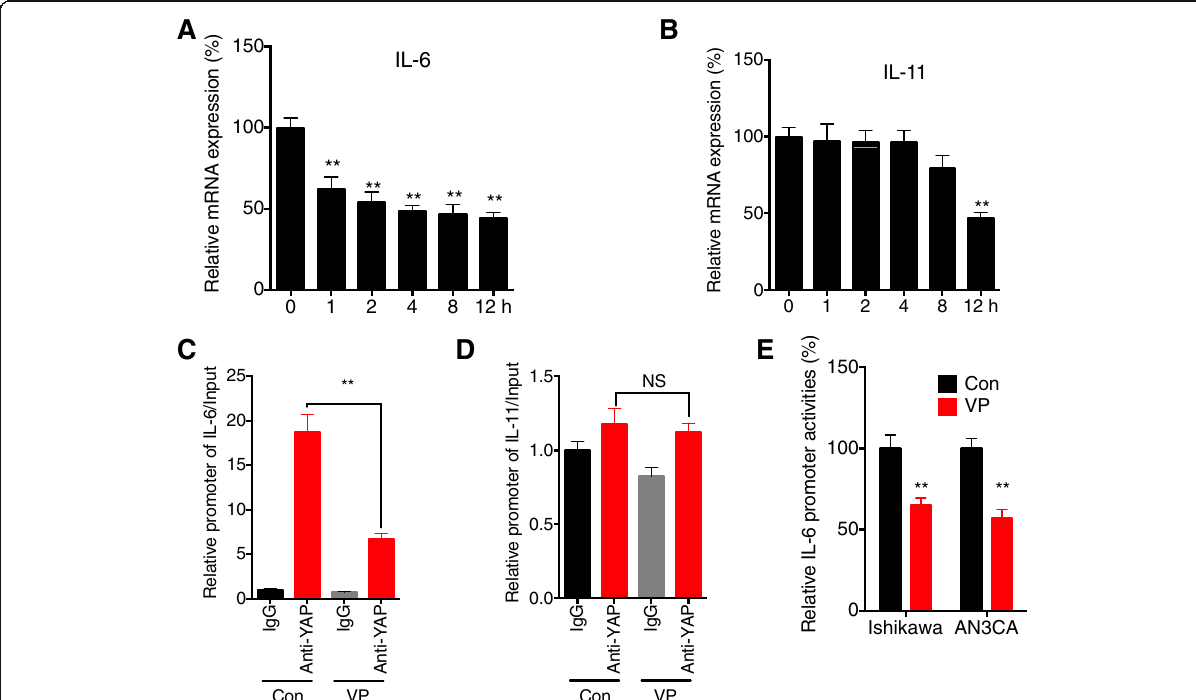
Fig. 5 YAP can directly regulate the transcription of IL-6, while not IL-11, in EC cells . Ishikawa cells were treated with 5 μ M of VP for the indicated times, the expression of IL-6 ( a ) and IL-11 ( b ) was measured by use of qRT-PCR; Ishikawa cells were treated with or without VP for 1 h, the binding between YAP and promoter of IL-6 ( c ) or IL-11 ( d ) was measured by ChIP assay; ( e ) Ishikawa or AN3CA cells were treated with or without VP for 1 h, the luciferase activities of IL-6 promoter were measured by use of the dual-luciferase assay. Data are presented as means ± SD of three independent experiments. * p < 0.05, ** p < 0.01 compared with